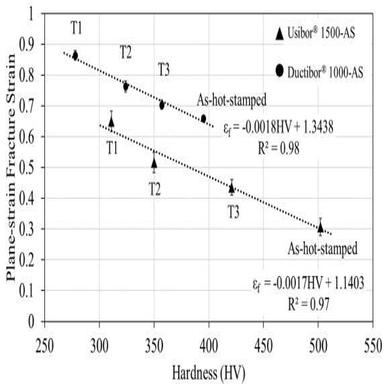
Linear relationship between fracture strain under in-plane plane strain conditions with hardness for as-hot-stamped and tempered martensitic (HAZ) conditions. As-hot stamped v-bend data for Usibor® 1500-AS due to Samadian et al. and for Ductibor® 1000-AS due Lee .